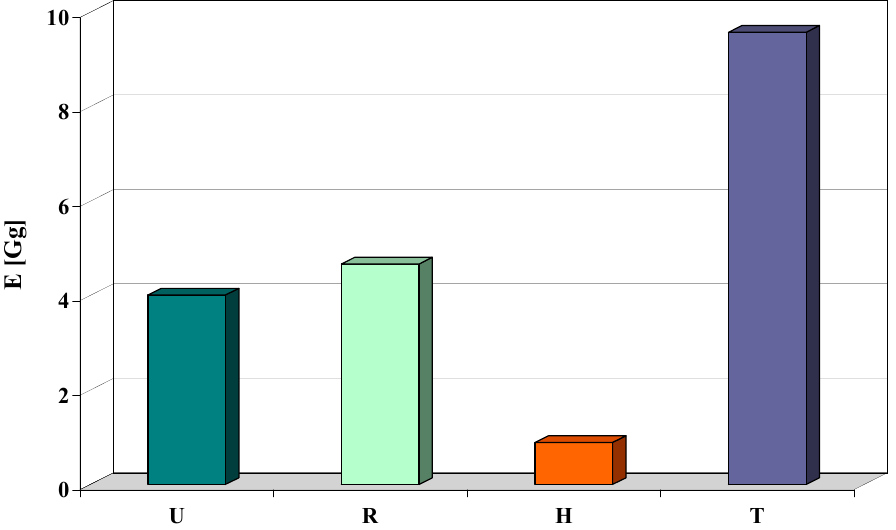
Figure 9. National annual emissions (E) of particulate matter PM10 (PM10-T) under different traffic conditions: urban (U), rural (R), highway (H) and total (T).